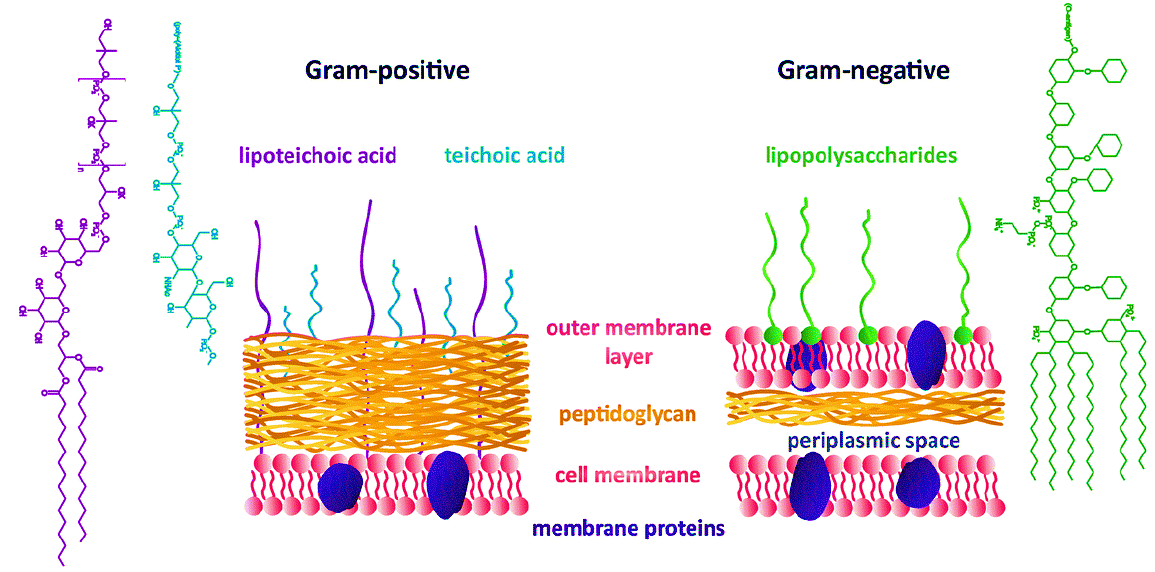
Figure 4. Comparison between the cell wall structure and composition of both Gram-positive and Gram-negative bacterial strains [39].